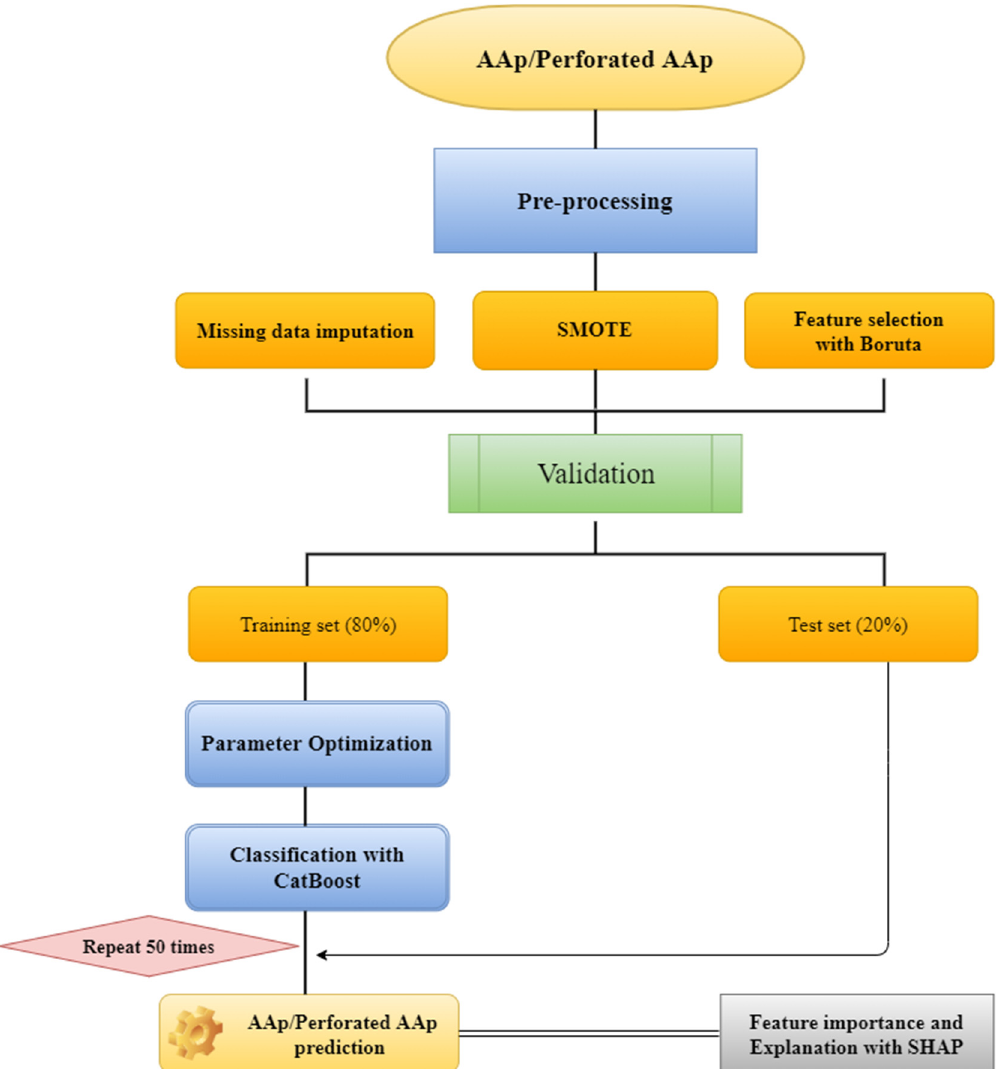
Figure 1. Diagram of the proposed method combining explainability and classifier.